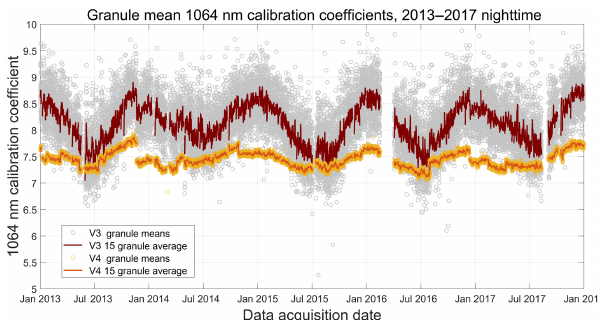
Figure 21. Granule-mean calibration coefficients (scaled by 10 − 9 , with units = km − 3 srJ − 1 count) for V3 and V4 from 1 Jan- uary 2013 through 31 December 2017. The large data gap from 28 January through 14 March 2016 is due to a GPS anomaly that interrupted the timekeeping services normally provided by the satel- lite. Adverse space weather is responsible for the smaller gap from 5 through 15 September